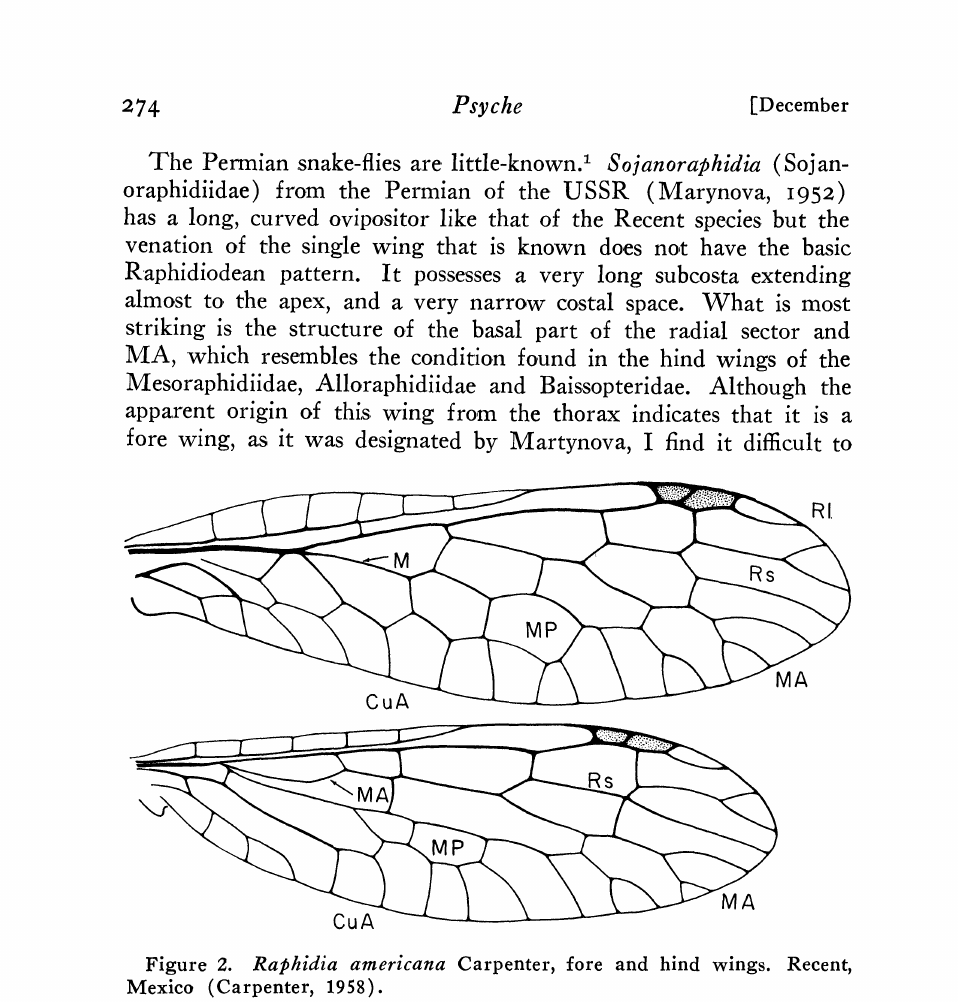
Figure 2. Raphidia americana Carpenter, fore and hind wings. Recent, Mexico (Carpenter,